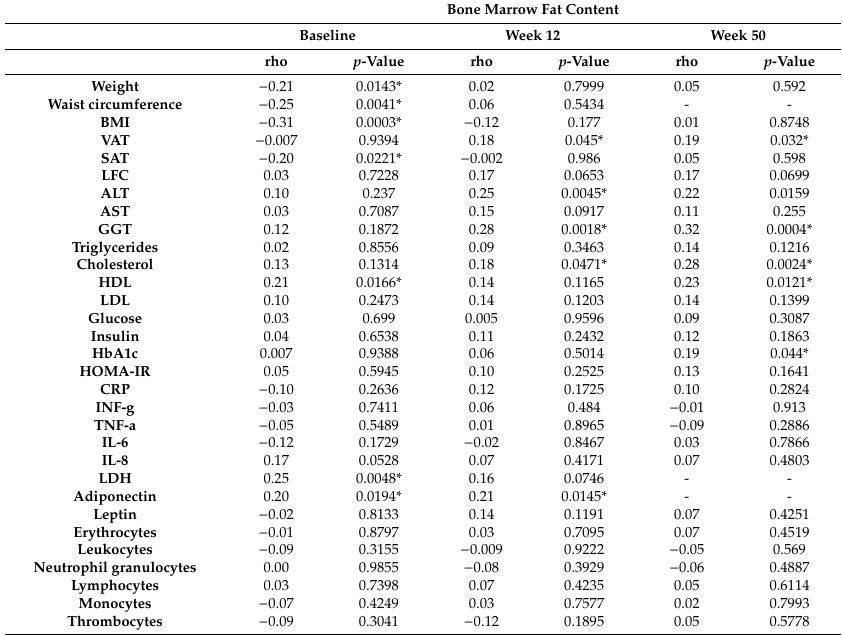
Table 2. Spearman’scorrelationsbetweenanthropometricparameters, metabolicparameters, inflammation parameters, blood cells and BMFC at baseline, after 12 weeks and after 50 weeks, n =